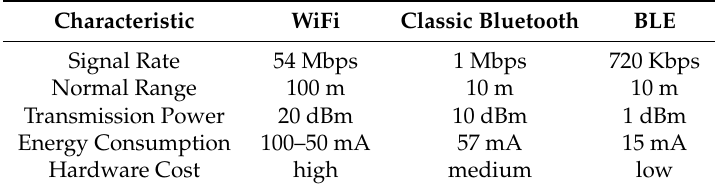
Table 1. Comparison of different wireless communication